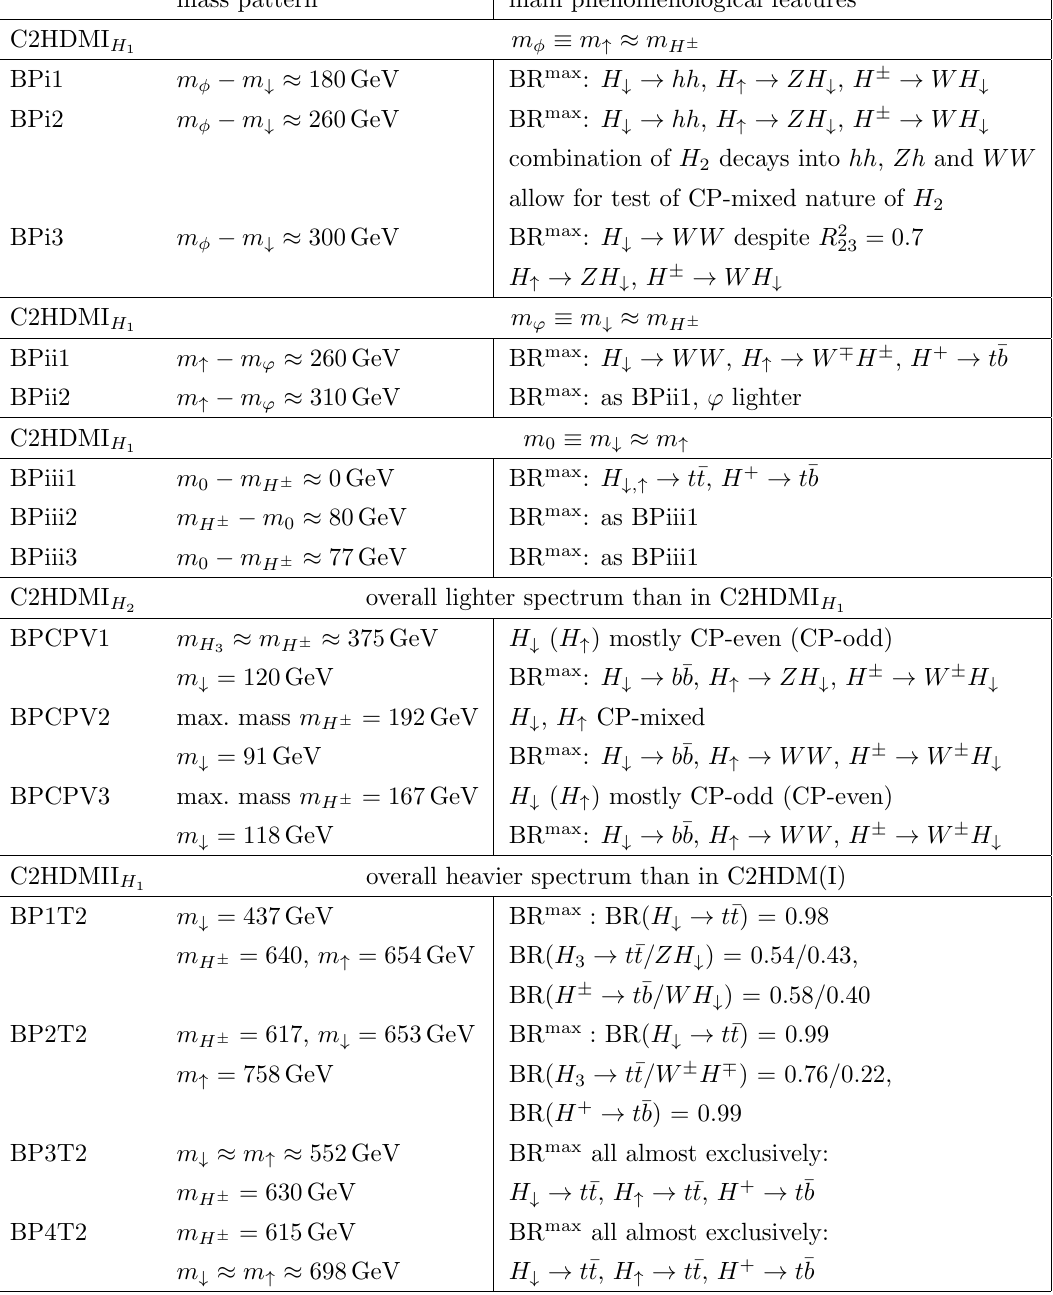
Table 12 . Main features of the CP-violating benchmark points with a strong phase